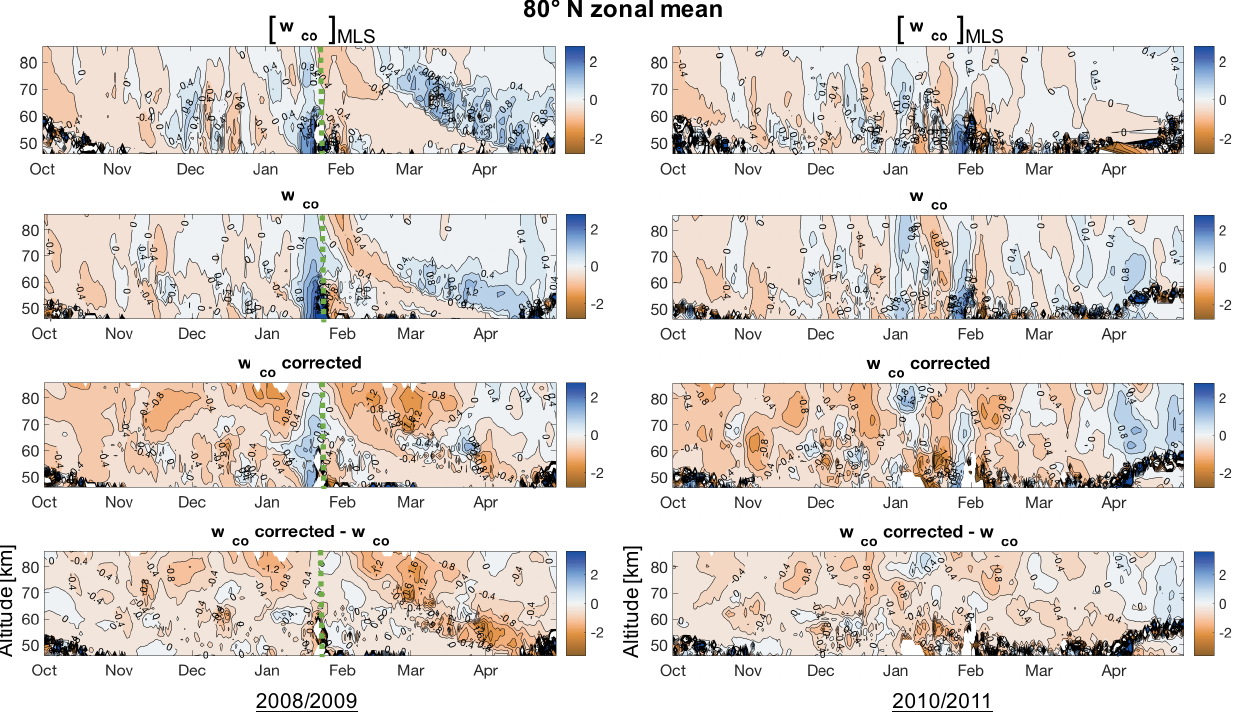
Figure 7. The same as Fig. 6, but for a zonal mean at 80 ◦ N, and including rates calculated using MLS CO data in the upper two panels, titled [ w CO ] MLS